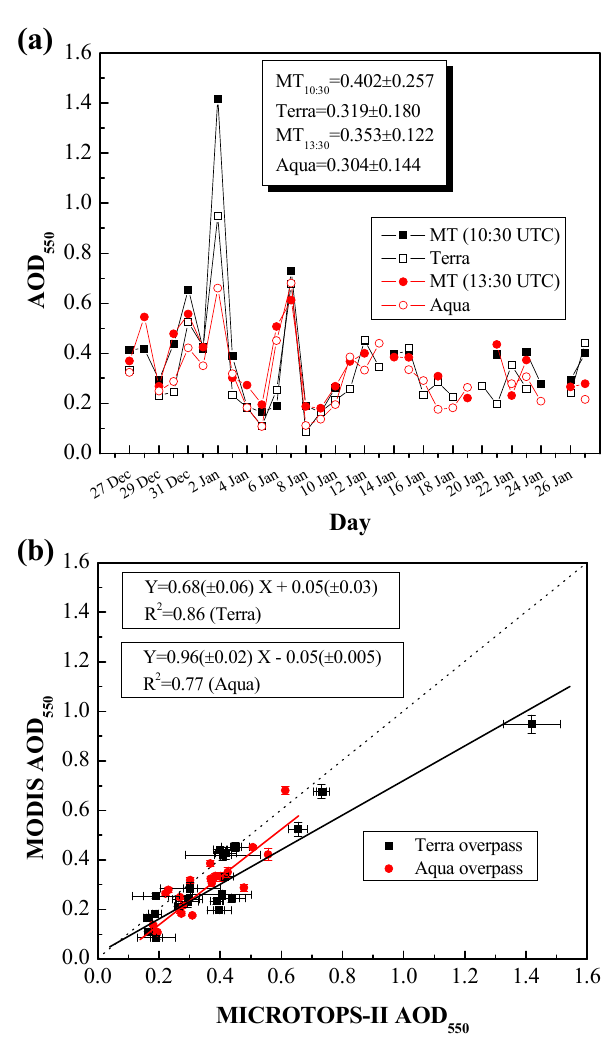
Fig. 12. Day-to-day variation of the AOD 550 obtained from Terra/Aqua MODIS and MICROTOPS-II, MT (a) , and their be- tween correlation (b) . The MODIS data correspond to area- averaged values (Level 3) along the daytime ship movement, while the MICROTOPS-II AOD 550 are the temporal-means within ± 30min of the Terra/Aqua overpass.